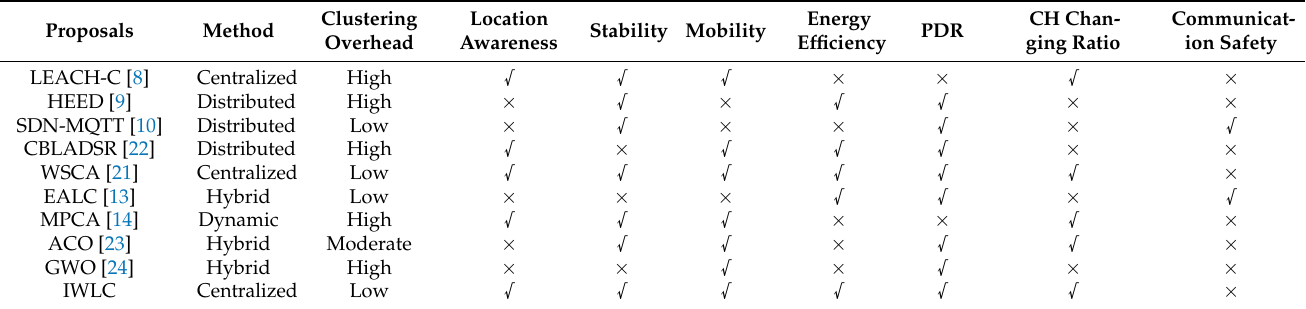
Table 1. IWLC performance positioning with other clustering schemes in FANETs.